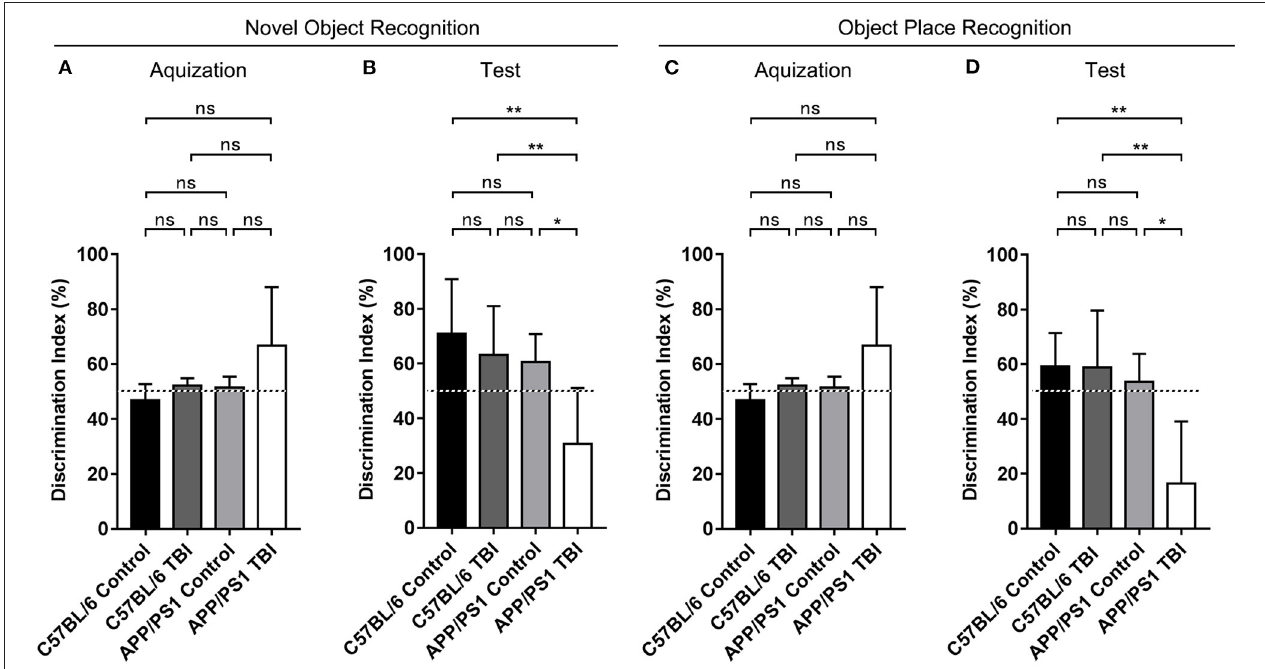
FIGURE 1 | The cognitive function of APP/PS1 mice deteriorated after TBI. Quantitative analyses of the discrimination indexes of C57BL/6, C57BL/6 TBI, APP/PS1, and APP/PS1 TBI group mice in the acquisition (A) and test phases (B) in the NOR test ( n = 8/group). Quantitative analyses of the discrimination indexes of C57BL/6, C57BL/6 TBI, APP/PS1, and APP/PS1 TBI group mice in the acquisition (C) and test phases (D) in the OPR test ( n = 8/group). ns, non-significant; * p < 0.05; ** p <